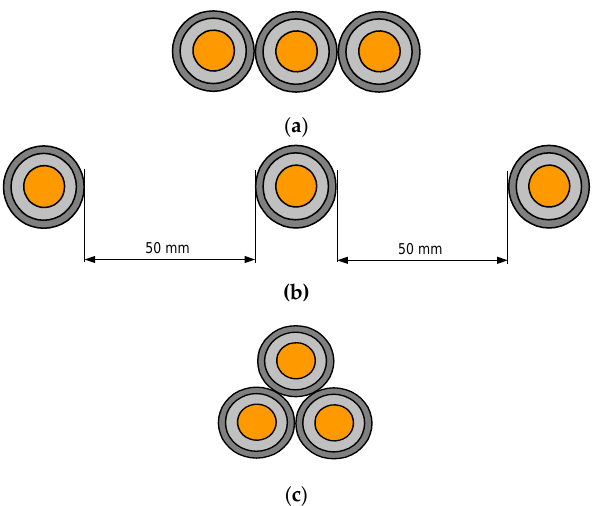
Figure 4. Considered horizontal layouts of the power cables: ( a ) flat formation without spacing; ( b ) flat formation with spacing 50 mm; ( c ) trefoil formation without spacing.